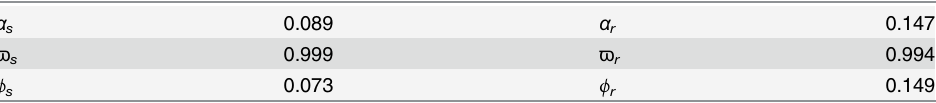
Table 3. Scalar adjustment of transmission probability. Scalar adjustment of transmission probability as derived through the calibration process for the result shown in Fig 2. Explanation of these parameters is given in the Methods and Fig